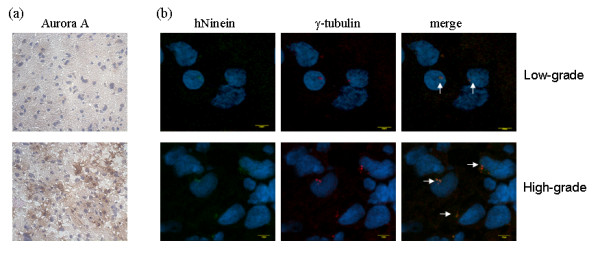
Aurora A, hNinein, and γ-tubulin expression in low- versus high-grade glioma. A, Immunohistochemical analysis of Aurora A expression (brown), 200× magnification. B, hNinein (green) and γ-tubulin (red), counterstained for DNA with DAPI (blue) was assessed by confocal microscopy. Bars = 10 μm, 1000× magnification.